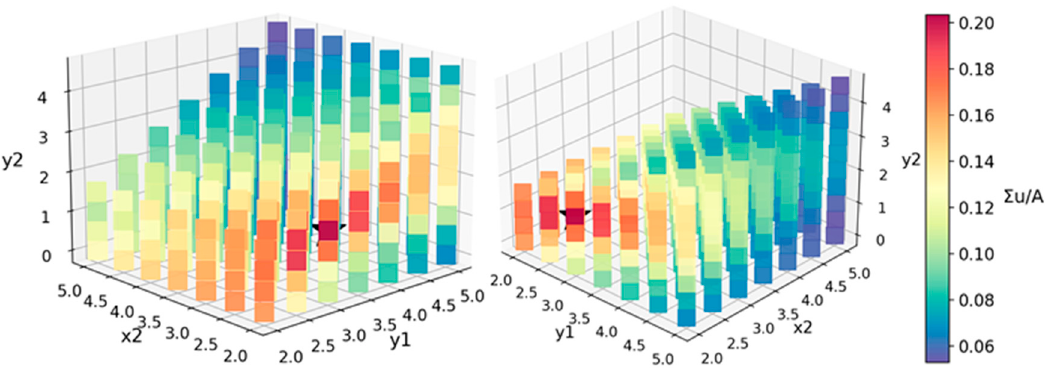
Figure 10. The three-dimensional scatter diagram of array power density. The left and right pictures are two different side views of the scatter. The three axes are the three distance parameters ( y 1, x 2, y 2). The color bar represents the array power density. The black star represents the maximum array power density (Its coordinates are y 1 = 3, x 2 = 2, y 2 = 1.5).